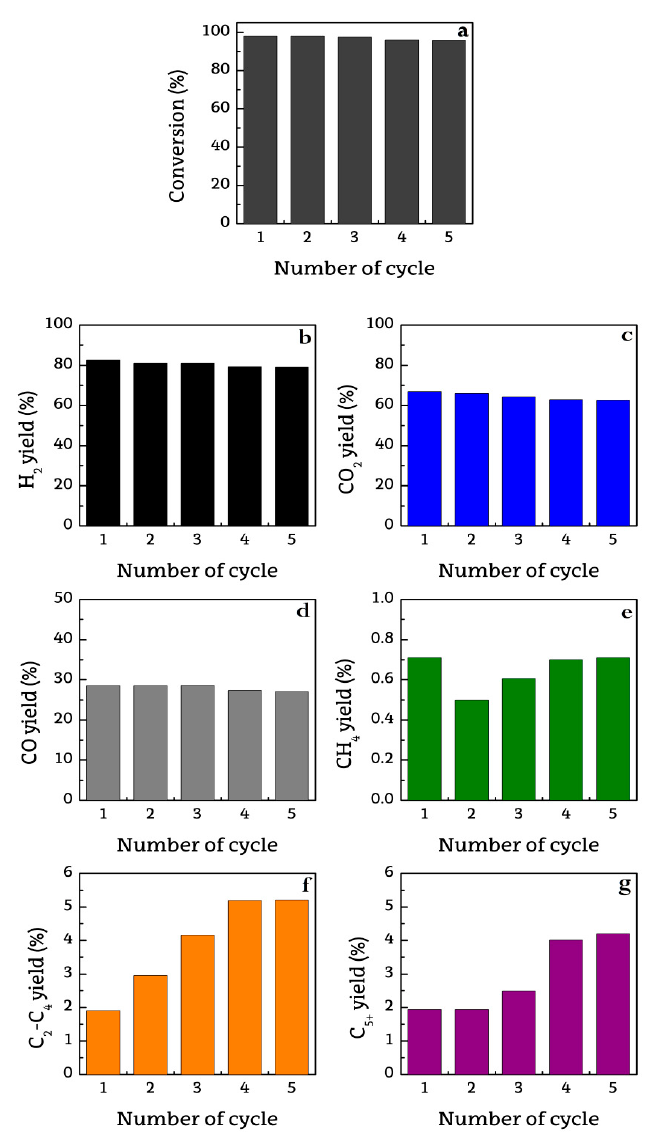
Figure 1. Evolution of conversion ( a ) and the yields of H 2 ( b ), CO 2 ( c ), CO ( d ), CH 4 ( e ), C 2 -C 4 hydrocarbon ( f ), and C 5+ hydrocarbons ( g ) at zero time on stream in successive reaction-regeneration cycles.